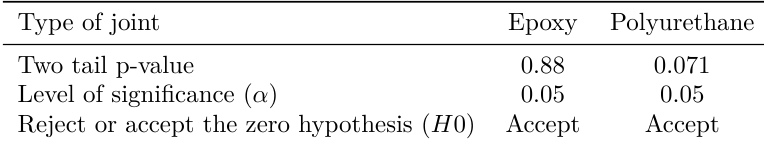
Table 5. Two-tail p-value results from wet bond versus dry bond.